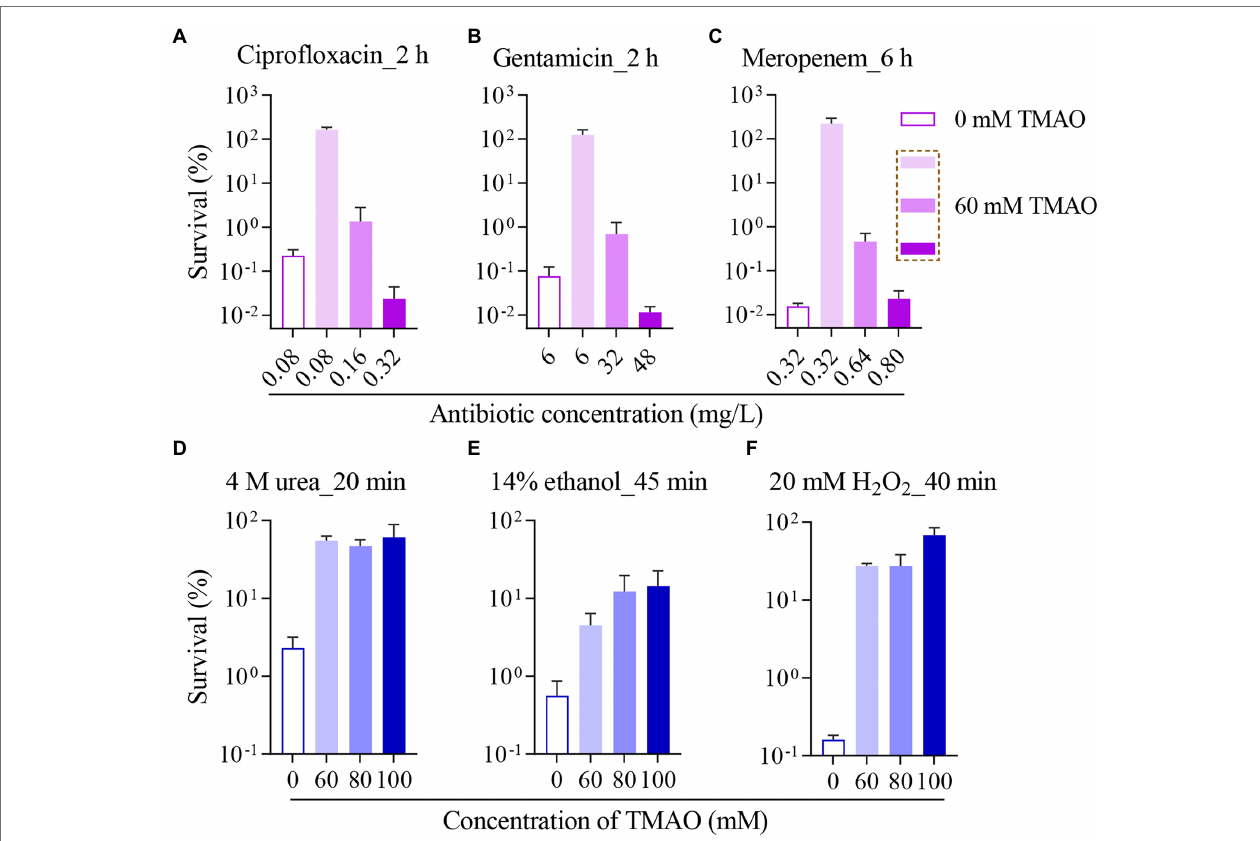
FIGURE 2 | Trimethylamine N-oxide protects Escherichia coli from killing by antibiotics or other lethal stressors. Survival of wild-type strain incubated with 0 or 60 mM TMAO, after ciprofloxacin treatment for 2 h (A) , gentamicin treatment for 2 h (B) , or meropenem treatment for 6 h (C) was measured. And survival of wild-type strain incubated with different concentrations of TMAO, after treatment with 4 M urea for 20 min (D) , 14% ethanol treatment for 45 min (E) , or after 20 mM H 2 O 2 treatment for 40 min (F) was measured. TMAO was added to the corresponding bacterial culture for co-incubation 30 min before antibiotic addition. Experiments were performed independently for three times. Each data plotted value represents mean ±